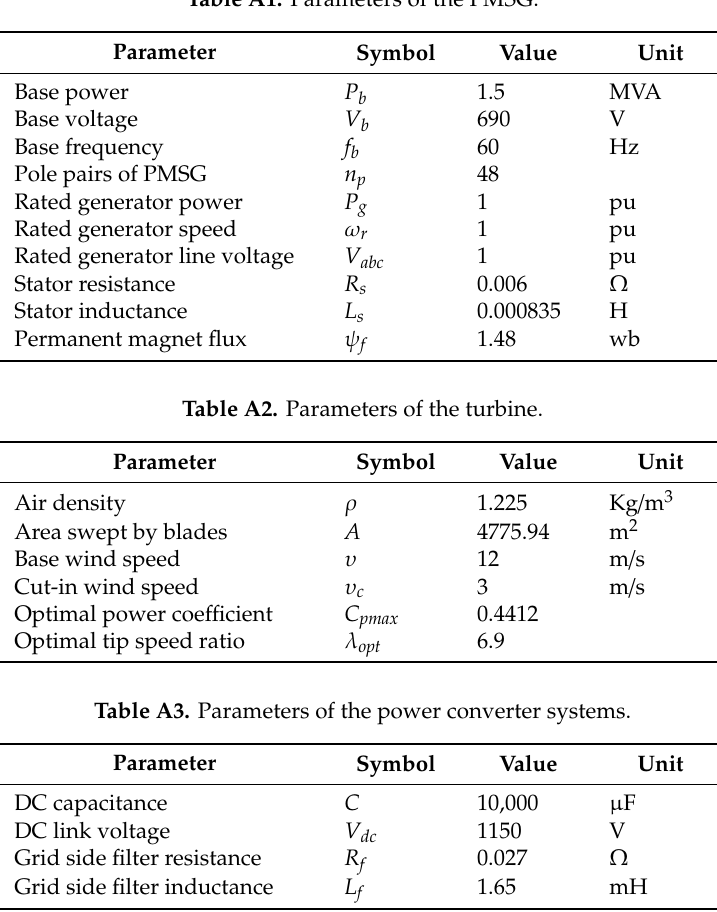
Table A1. Parameters of the PMSG.